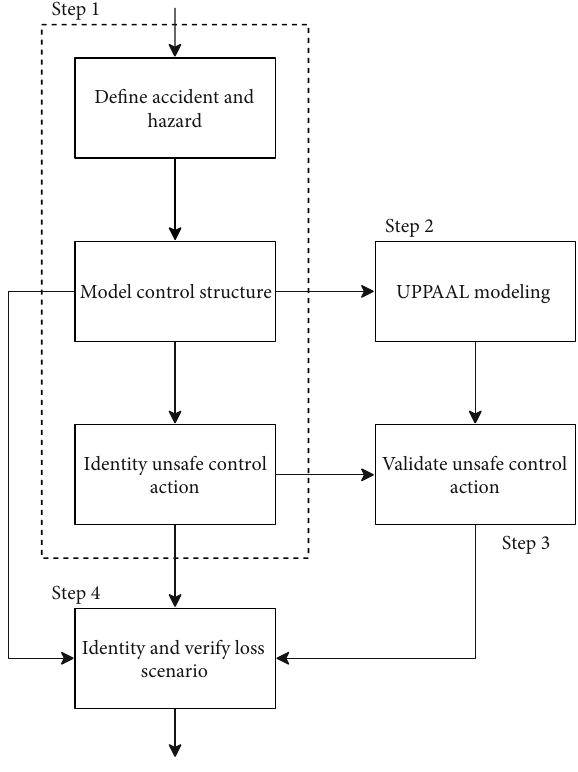
Figure 5: STPA-UPPAAL